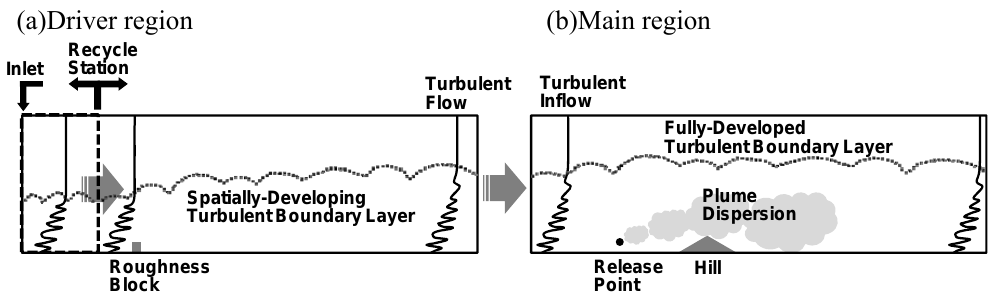
Fig. 1. Schematic illustration of computational model. (a)Driver region for generation of Figure 1. Schematic illustration of computational model. (a) Driver region for generation of a spatially-developing TBL flow and (b) main region for plume dispersion over a spatially-developing TBL flow and (b)main region for plume dispersion over hill.